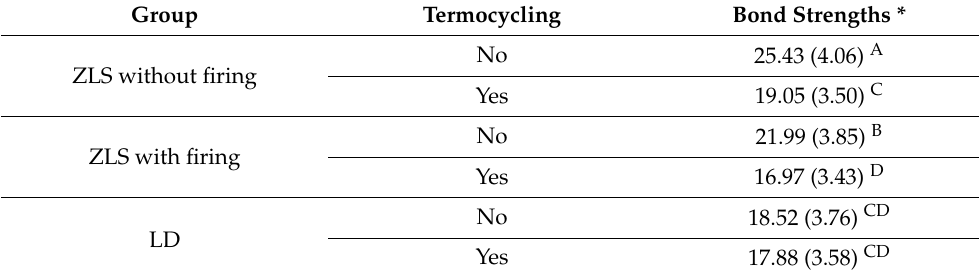
Table 5. Bond strengths mean and standard deviation according to the experimental groups. Group